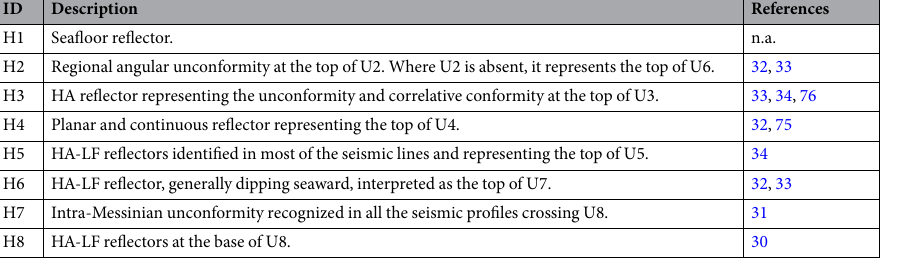
Table 3. Horizons. Notes: HA = high amplitude; LF = low